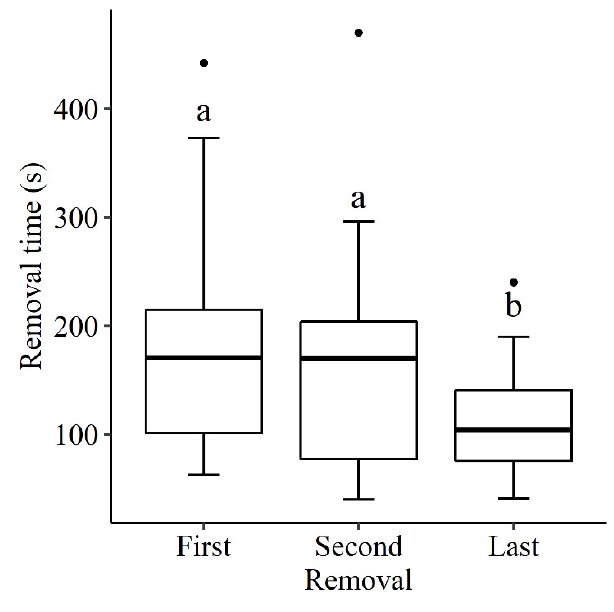
Fig 4 . After the first diaspore removal, Ectatomma edentatum remove diaspores more quickly. The x -axis indicates which diaspore removal (first, second and last) and the y-axis indicate removal time in seconds (s). The centreline of each boxplot indicates the median of all values, and the boxes indicate the first quartile (median of the values above the central median) and third quartile (median of the values below the central median). The vertical lines of each boxplot are the Tukey-style whiskers (1.5 × interquartile range). The circle above the boxplot is an